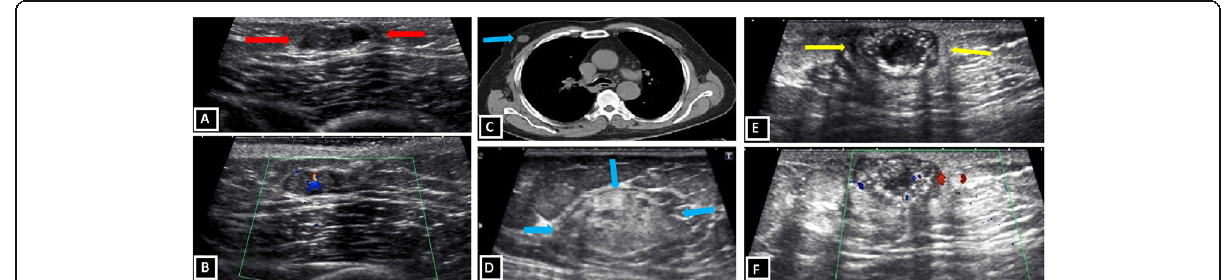
Fig. 9 Benign neoplastic breast lesions. a , b Intraductal papilloma. Retroareolar well-defined solid nodule (red arrows) within a dilated duct is demonstrated in a 40-year-old patient with nipple discharge ( a ). Doppler ultrasound shows stalk of internal vascularity within the solid nodule ( b ). c , d Myofibroblastoma. Non-contrast CT scan displays well-defined round incidental mass (blue arrows) in right breast ( c ). US image shows circumscribed mass with mixed echogenicity and posterior acoustic shadowing due to internal fat content ( d ). e , f Pilomatricoma. Well-defined, lobulated complex mass with solid and cystic areas, hyperechoic spots, posterior acoustic shadowing (yellow arrows) and internal